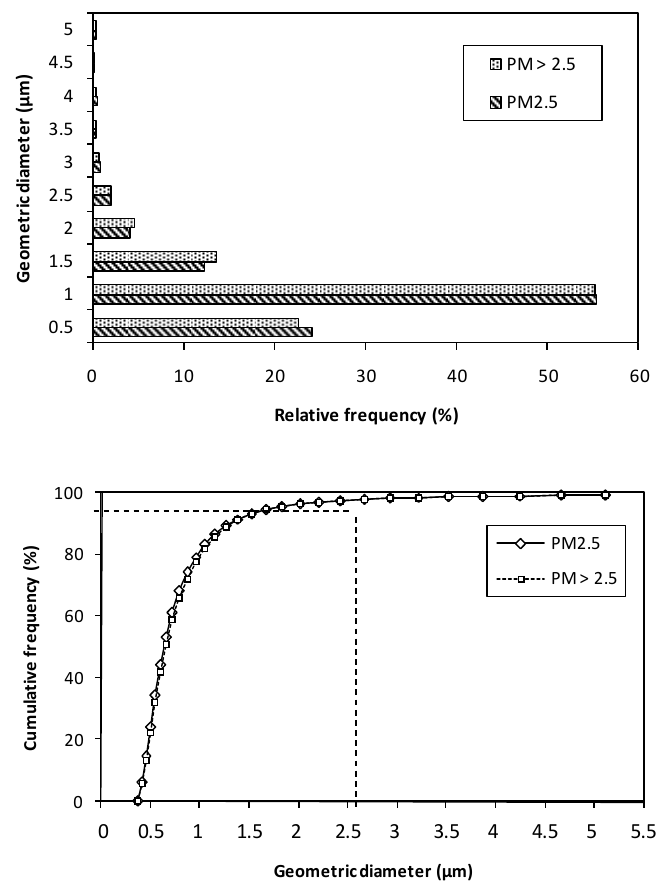
Figure 2. Size distribution by cumulative frequency (%) and relative frequency (%) of PM 2.5 and PM >2.5 collected in an urban site, Cotonou. Table 1. Concentrations of fine and coarse particles and inorganic water-soluble ions measured in different